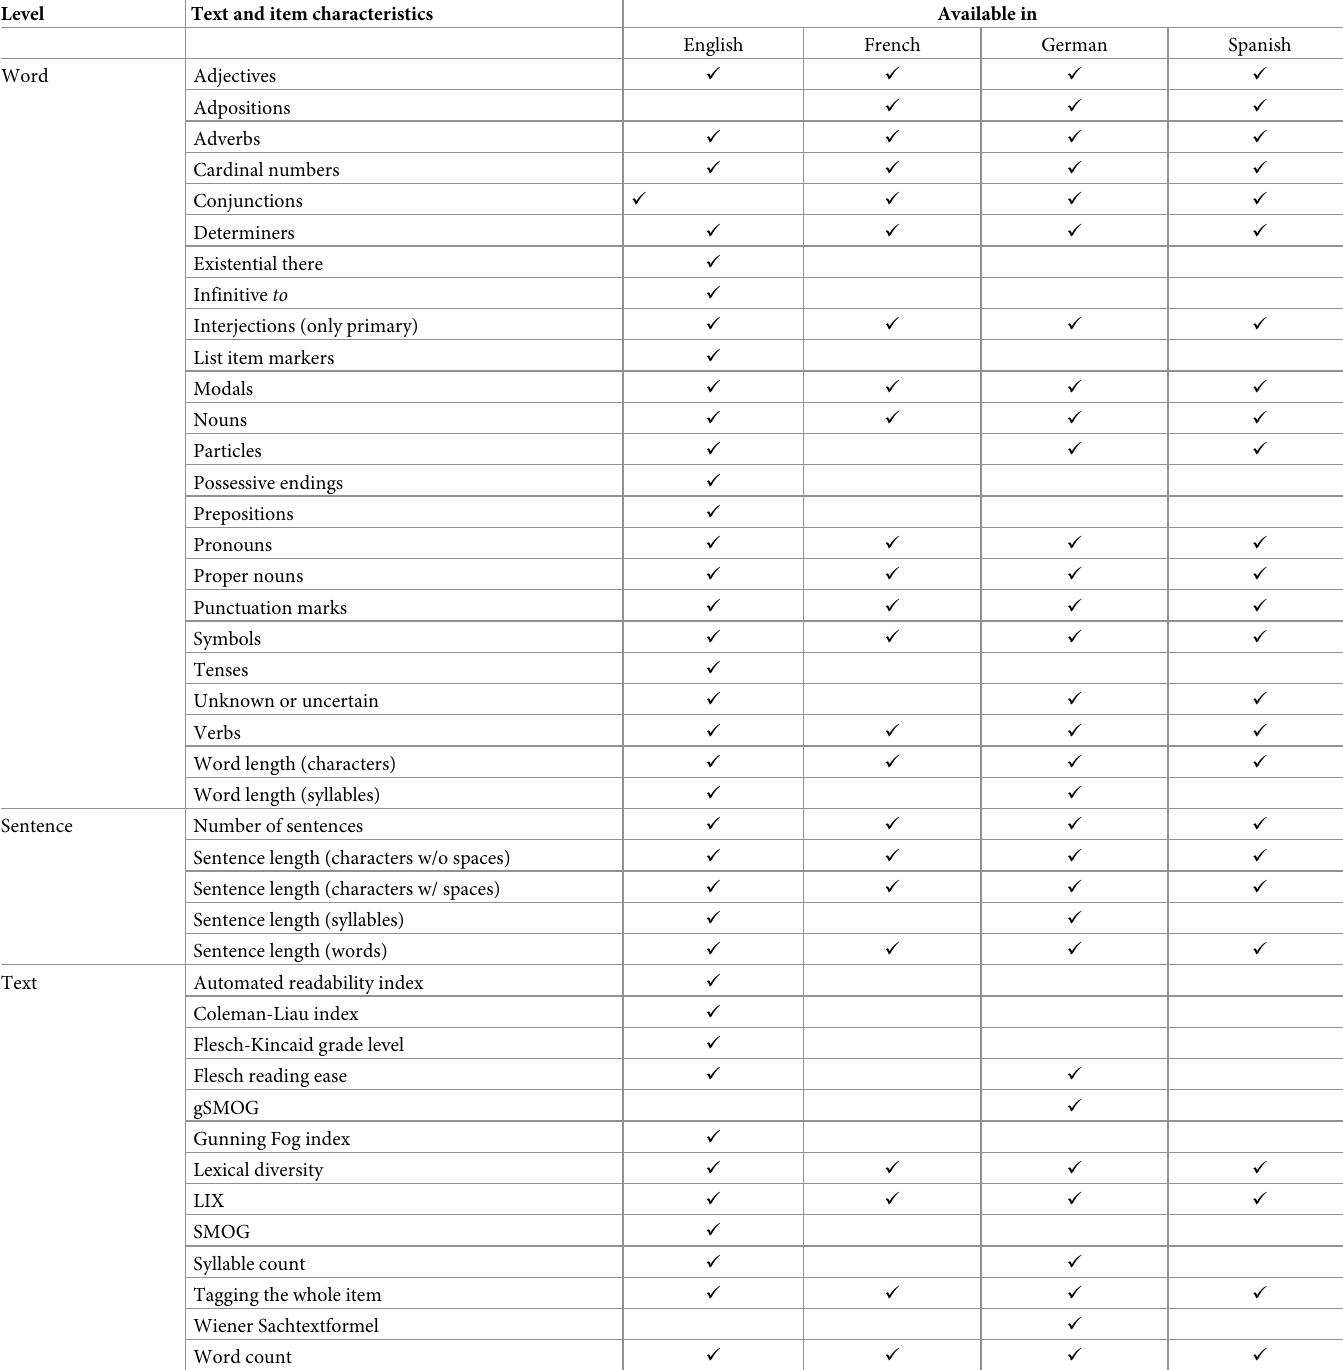
Table 1. Overview of LATIC’s features. Level Text and item